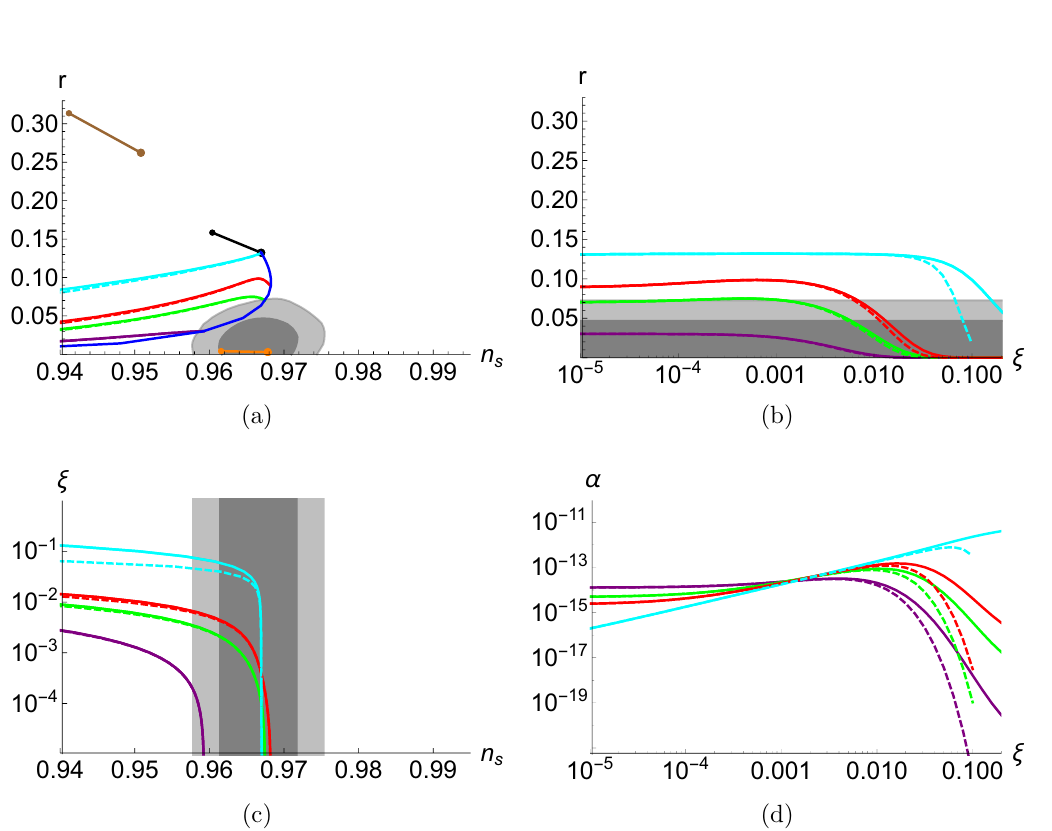
Figure 9. r vs. n s (a), r vs. ξ (b), ξ vs. n s (c) and α vs. ξ (d) for δ = 40 , 70 , 100 , 1000 respectively in purple, green, red and cyan with N e = 60 e -folds in region 2. Continuous/dashed line represents metric/Palatini gravity. For reference we plot the predictions of CW inflation for N e = 60 (blue), R 2 (orange), χ 2 (black) and χ 4 (brown) inflation for N e ∈ [50 , 60] . The gray areas represent the 1,2 σ allowed regions from Planck 2018 data [6].